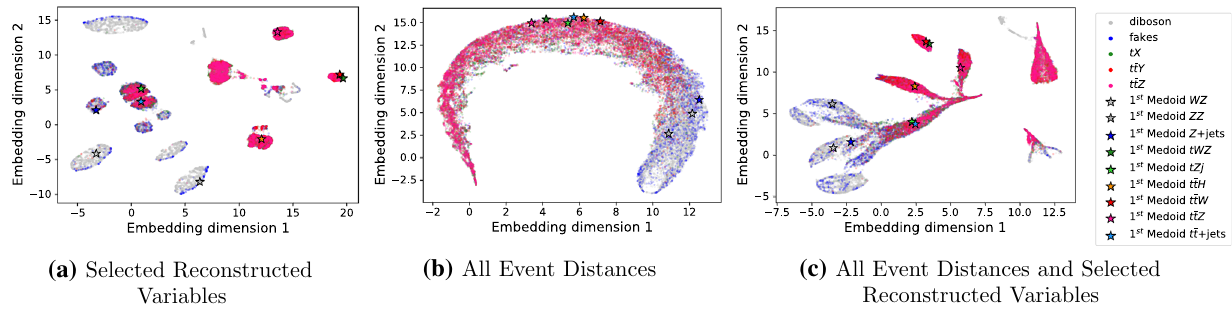
Fig. 5 UMAP projections of three combination of features. The triangles show the 1st medoid of each sample according to the d ( I , J ) (cid:2) E distance. Units of final embedding space are arbitrary